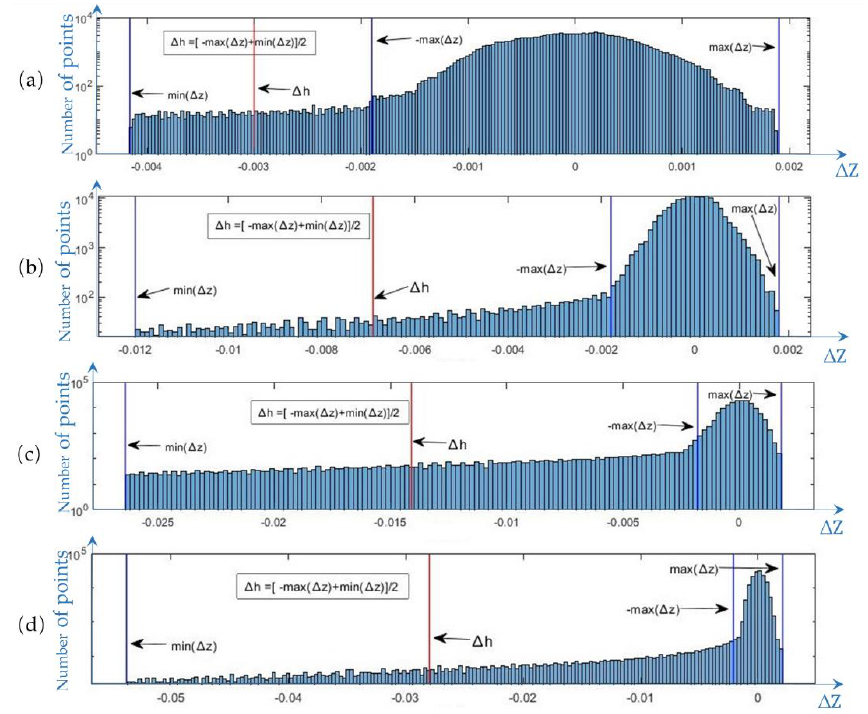
Figure 8. Height difference results (profile through the subsidence center, m).